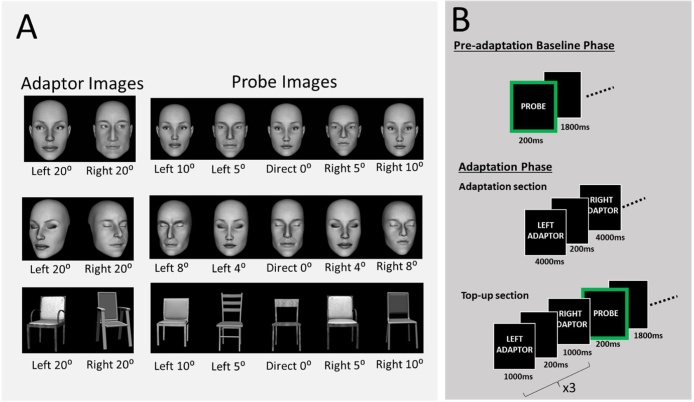
Sample stimuli, trial format, and procedure for the different adaptation tasks. (A) Examples of the social (eye-gaze, head direction) and non-social (chair orientation) stimuli used in the three tasks. (B) All three tasks had the same format comprising (i) a pre-adaptation baseline phase and (ii) an adaptation phase. An additional post-adaptation baseline phase also takes place but these data are not analysed. In the baseline phases participants categorised the direction (left, direct, or right) of probe images (green border) oriented in one of five directions. The adaptation phase consisted of two sections. In the adaptation section participants adapted to an alternating series of 20° left and 20° right oriented adaptors and in Section 2 the baseline phase was repeated with every probe image preceded by six top-up adaptor images. The primary outcome measure of adaptation magnitude is the change in the percentage of ‘direct’ responses made to the averted probe images in the adaptation phase relative to the pre-adaptation baseline. Participants completed these three phases three times, once for each stimulus type (eye-gaze, heads, and chairs) in a counterbalanced order for both experiments.